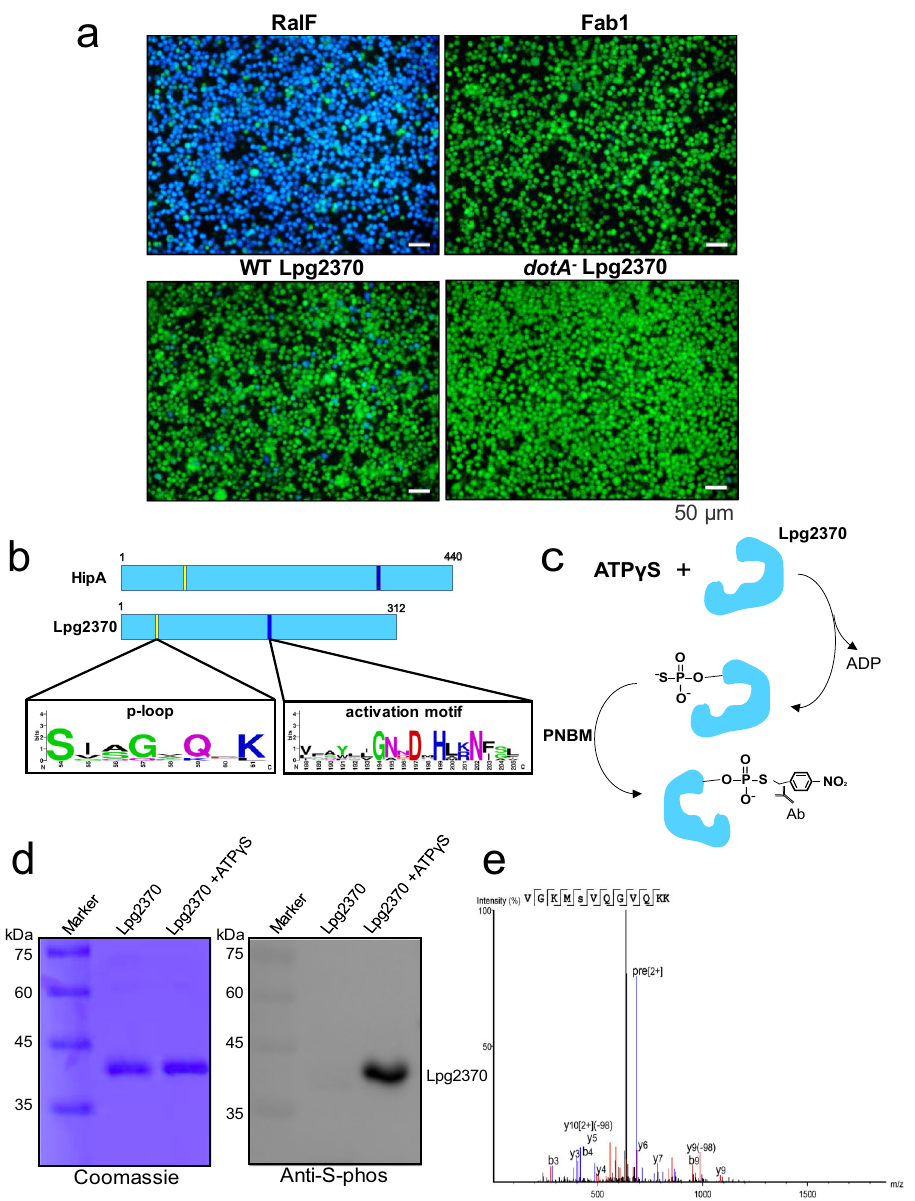
Fig.1| L.pneumophila effectorLpg2370isaSer/Thrkinase.a TEM-1 β -lactamase translocation assay demonstrates that Lpg2370 is a L . pneumophila effector pro- tein. RAW264.7 cells were challenged with a T4SS-competent wild-type L. pneu- mophila strain Lp02 or the dotA-mutant de fi cient strain Lp03 carrying plasmids encoding TEM-1-RalF (positive control), TEM-1-FabI (negative control), or TEM-1- HipT Lp . T4SS-mediated translocation of the fusion proteins into host cells was assessed 2h after infection by the CCF4-AM-based fl uorescence resonance energy transfer assay, scale bars 50 μ m. b Schematic of Lpg2370 and the Ser/Thr kinase HipAfrom E.coli K-12(HipA Ec ).Yellowandblue regionsrepresentthe